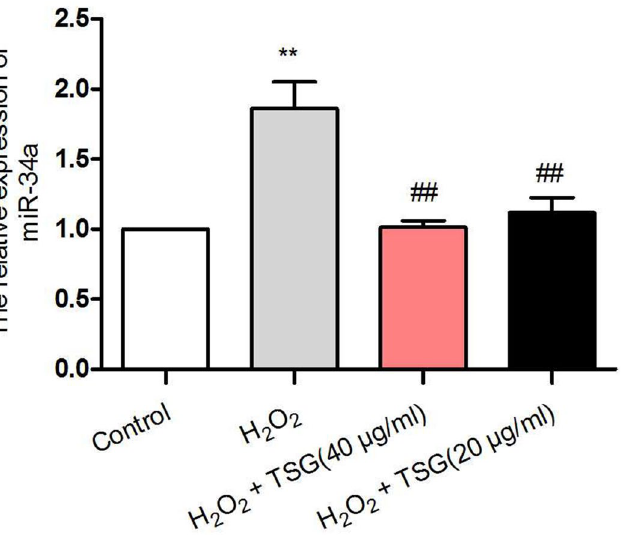
Figure 1. TSG inhibited miR-34a expression in H 2 O 2 -induced HUVECs. To assess the effect of TSG on miR- 34a expression, after pretreatment with TSG (40 μg/ml) or TSG (20 μg/ml) for 24 h, HUVECs were exposed by H 2 O 2 for 2 h, total RNA was extracted and the level of miR-34a was detected by qRT-PCR. Results are expressed as the means ± SD. ** p < 0.01 vs. control, ## p < 0.01 vs. H 2 O 2